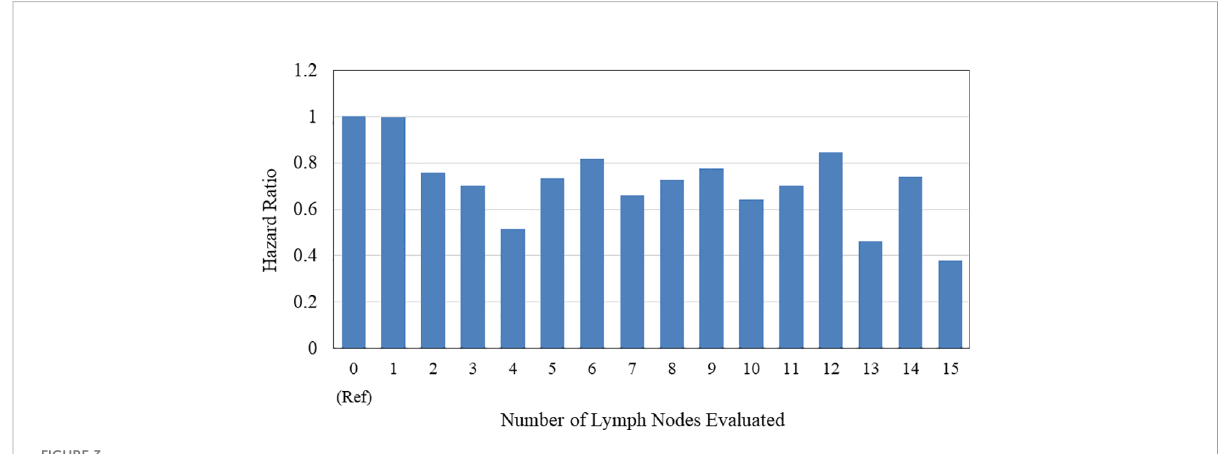
FIGURE 3 Hazard ratios for death by the number of lymph nodes evaluated are